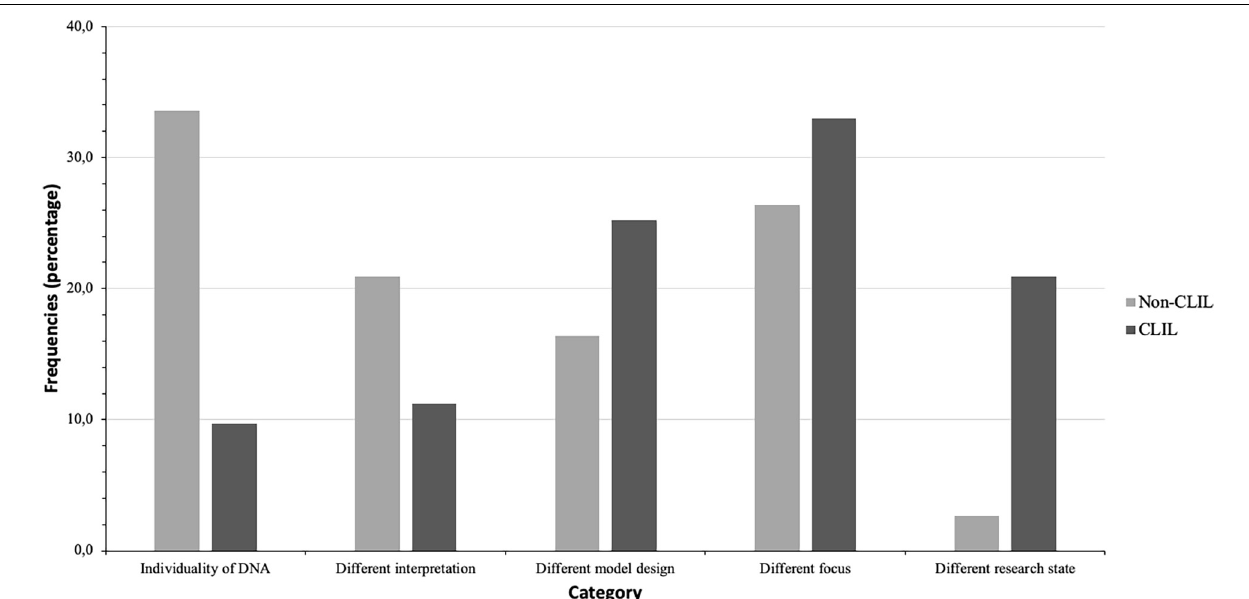
FIGURE 6 | Category frequencies of the open question “Explain why one might create different models of one biological original (in our case, the structure of the DNA)” for non-CLIL and CLIL